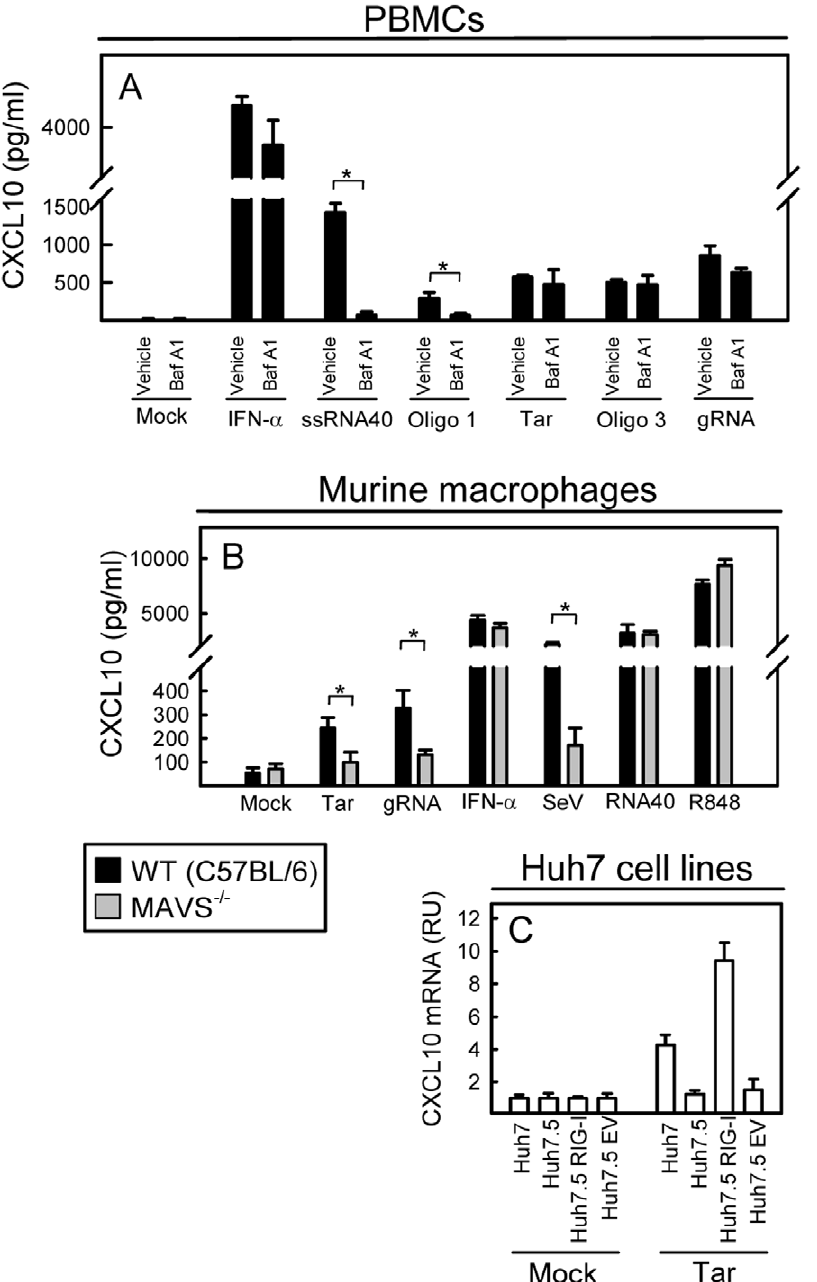
Figure 5. The innate immune response induced by HIV genomic RNA or RNA oligos is dependent on RIG-I and MAVS. (A) PBMCs were treated with bafilomycin A1 (0.5 m M) as indicated 15 min prior to stimulation with genomic HIV RNA, RNA oligos, or ssRNA40 (all 2 m g/ml). IFN- a was included as a positive control (10 ng/ml). Supernatants were harvested 18 h post stimulation for measurement of CXCL10. (B) BMMs from C57BL/6 wildtype and MAVS 2 / 2 mice were stimulated with genomic HIV RNA (2 m g/ml), Tar (2 m g/ml), Sendai virus (MOI 1), IFN- a (10 ng/ml), ssRNA40 (2 m g/ ml), or R848 (2 m g/ml). Supernatants were harvested after 16 h and CXCL10 was measured by ELISA. UT, untreated cells. Data are shown as means of triplicates + / 2 st.dev. (C) Huh7, Huh7.5 (RIG-I mutant), Huh7.5 EV (empty vector), and Huh7.5 RIG-I cells were transfected with Tar RNA (2 m g/ml), or subjected to mock transfection with Lipofectamine 2000. Total RNA was harvested 6 h later and CXCL10 mRNA levels were analysed by qPCR. Data are shown as means of triplicates + / 2 st.dev. Similar results were obtained in two or three independent experiments. Mock, Lipofectamine 2000 alone. RU, relative units *, p , 0.05. doi:10.1371/journal.pone.0029291.g005 by autophagy [49]. Using bafilomycin A1, an inhibitor of reduction of CXCL10 synthesis observed in cells deficient in RLR- triggered signaling through MAVS, this corroborates the finding endolysosomal acidification and TLR signaling, we observed no significant inhibition of the innate response to genomic RNA or that HIV genomic RNA is sensed primarily by cytosolic RIG-I secondary structured RNA oligos. Together with the strong rather than endocytic TLRs in PBMCs. This is in agreement with